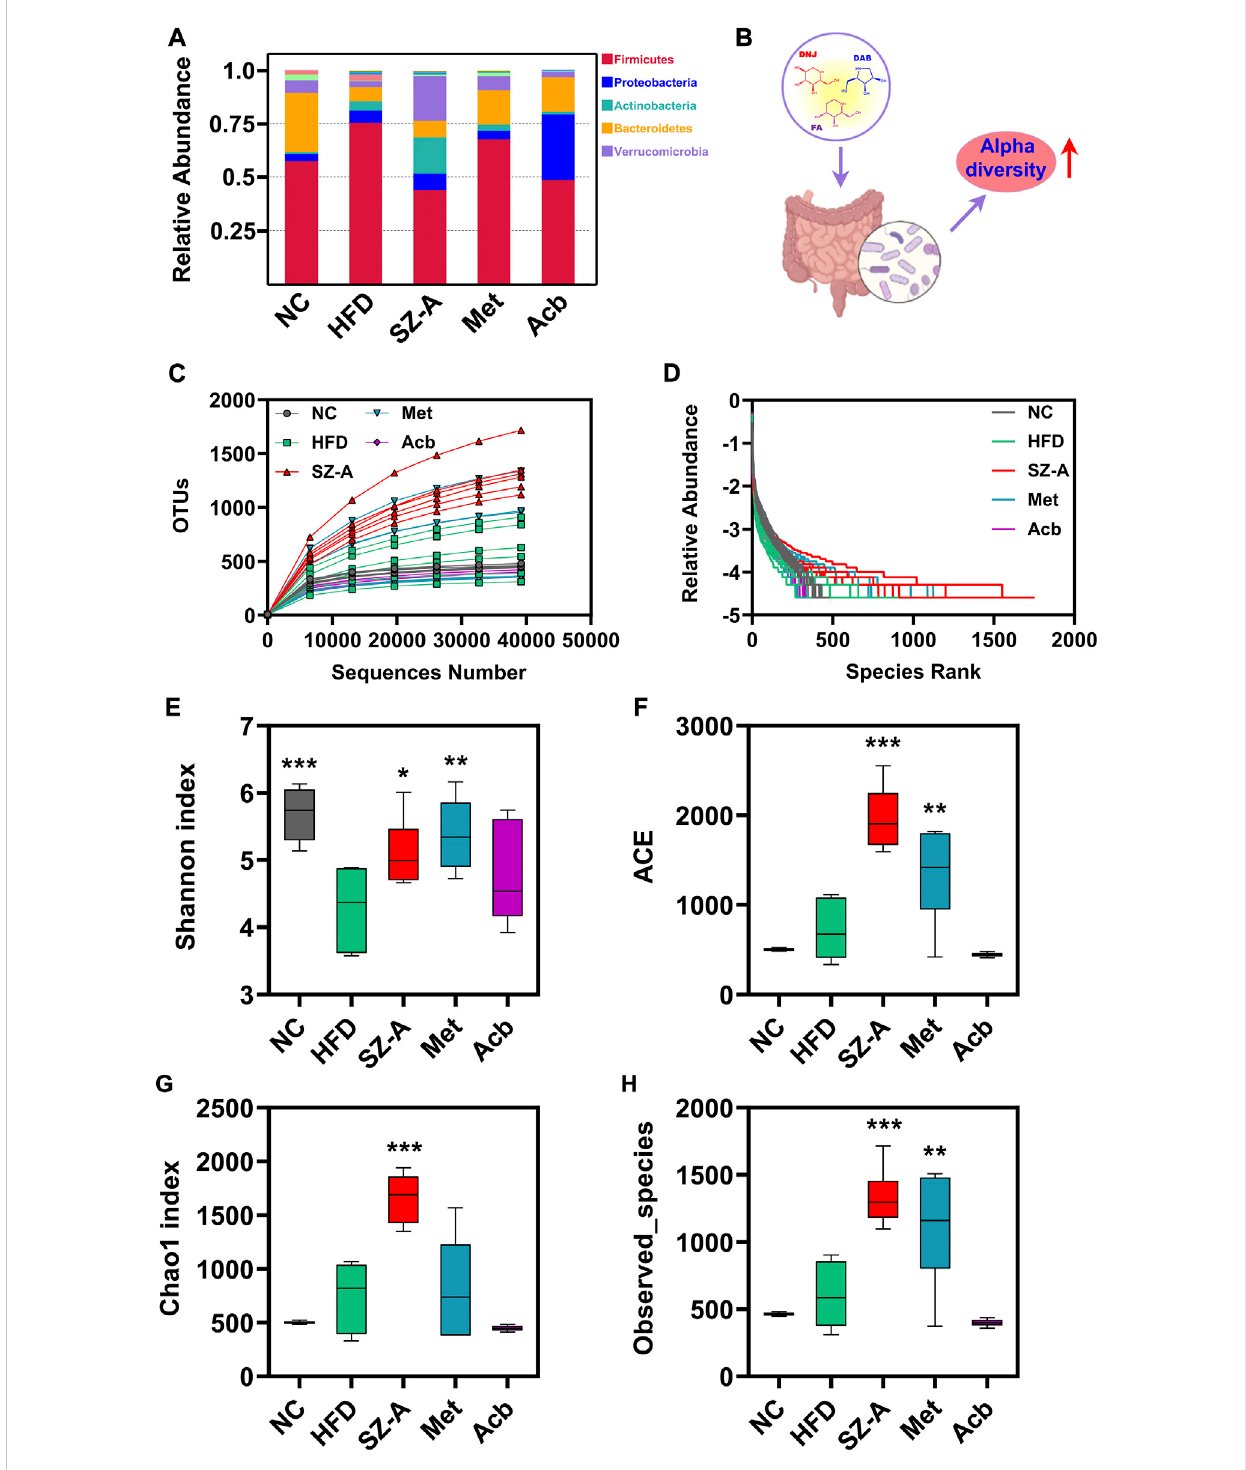
FIGURE 2 The gut microbiota diversity and richness of HFD-induced obese mice were improved by SZ-A through alpha diversity analysis. (A) Relative abundance of species columnar cumulative plot. (B) Alpha diversity indices increased after treatment with SZ-A. (C) Rarefaction curve. (D) Rank abundancecurve. (E – H) Fouralphadiversityindices(Shannon,ACE,Chao1,andObserved_species)werecalculated( n =6).Thecomplexityofthesample community could be re fl ected by the index values. Each value is expressed as mean ± SEM. *** p < 0.001, ** p < 0.01. * p < 0.05 compared with